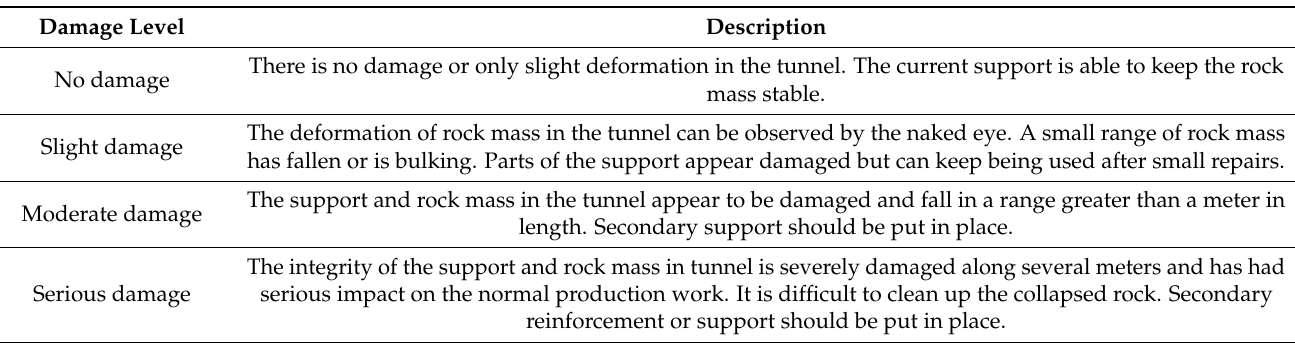
Table 1. Description of the different damage levels of the